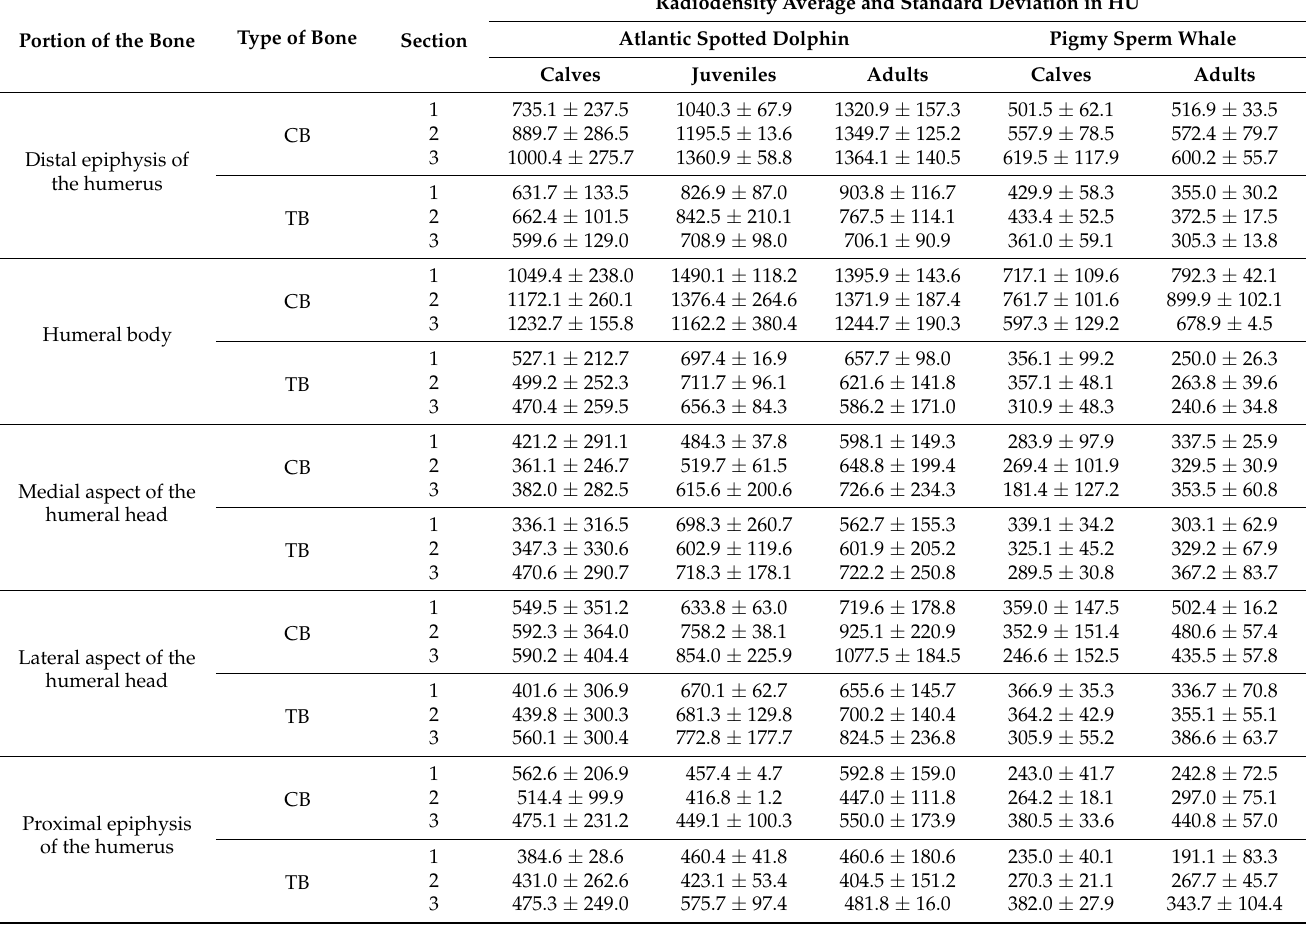
Table 4. Summary table of the averages and standard deviation in HU, obtained, for the different age categories of the two cetacean species, considering the radiodensity values of the two types of bone in the various sections. Abbreviations: CB, cortical bone; TB, trabecular